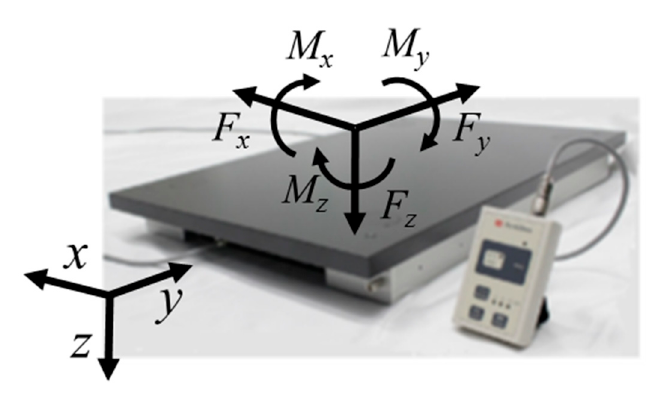
Figure 1. Force plate installed with the 5-axis load cells and definition of strain values about force and moment measured by load cells and the definition of global coordinate system and force plate